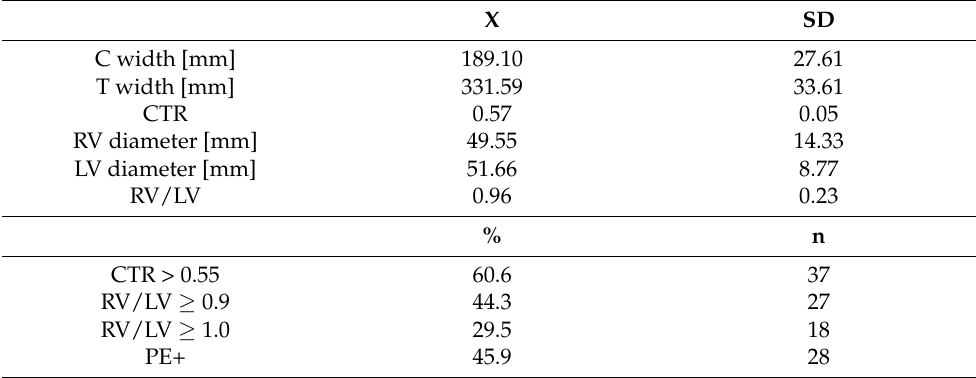
Table 3. The size of the heart silhouette in the chest radiograph and selected variables in the CTA examination of the pulmonary arteries in the study